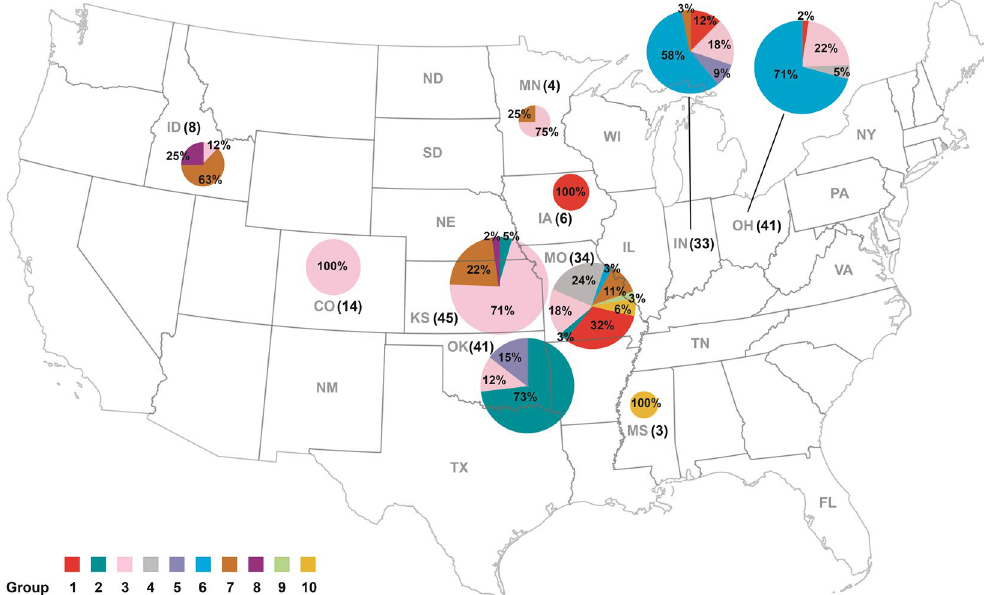
Figure 2. Distribution of B . canis genotype groups in different states. Number in brackets after the state abbreviation indicate total positives in that state; pie chart indicates percentages of each genotype group in that state. Pie size corresponds to the number of isolates. Those with state abbreviations but without a number indicate samples that were collected but all tested negative (number of submission are shown in Table 1). No sample was collected from those that do not have the state abbreviation. Different colors indicate different genotype groups. Red: genotype group 1; dark teal: group 2; pink: group 3; gray: group 4; lavender: group 5; light teal: group 6; orange: group 7; maroon: group 8; light green: group 9; and light orange: group 10. The map template was downloaded from www.vectortemplates.com (Graphics Factory CC, Western Cape, Sourth Africa) with